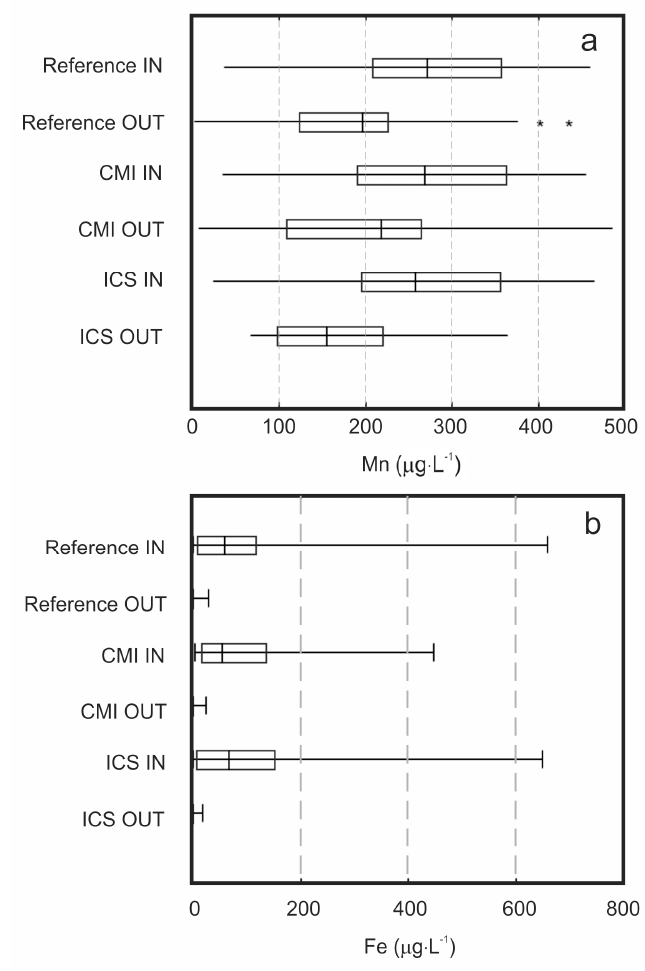
Figure 6. Box plot representation of the measured concentration of ( a ) manganese and ( b ) iron in the influents (IN) and effluents (OUT) of the three filters. Total (average) population for both samples was ~150 measured points. Outliers are represented by stars.